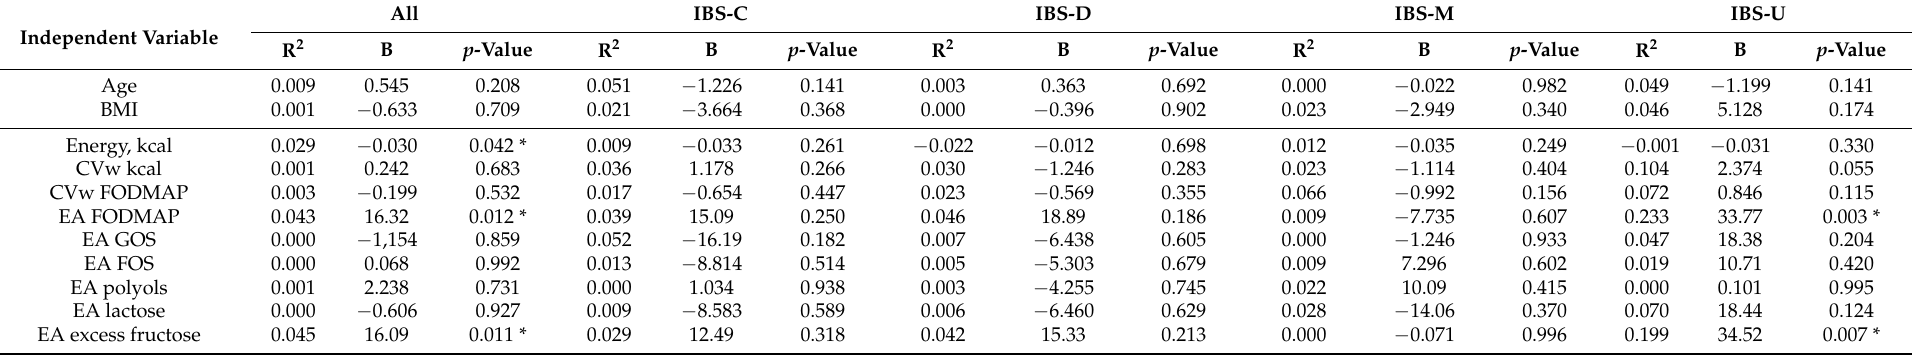
Table 4. Univariable linear regression investigating associations between age, BMI and dietary components and IBS symptom severity in women and divided into IBS subtypes. Independent Variable